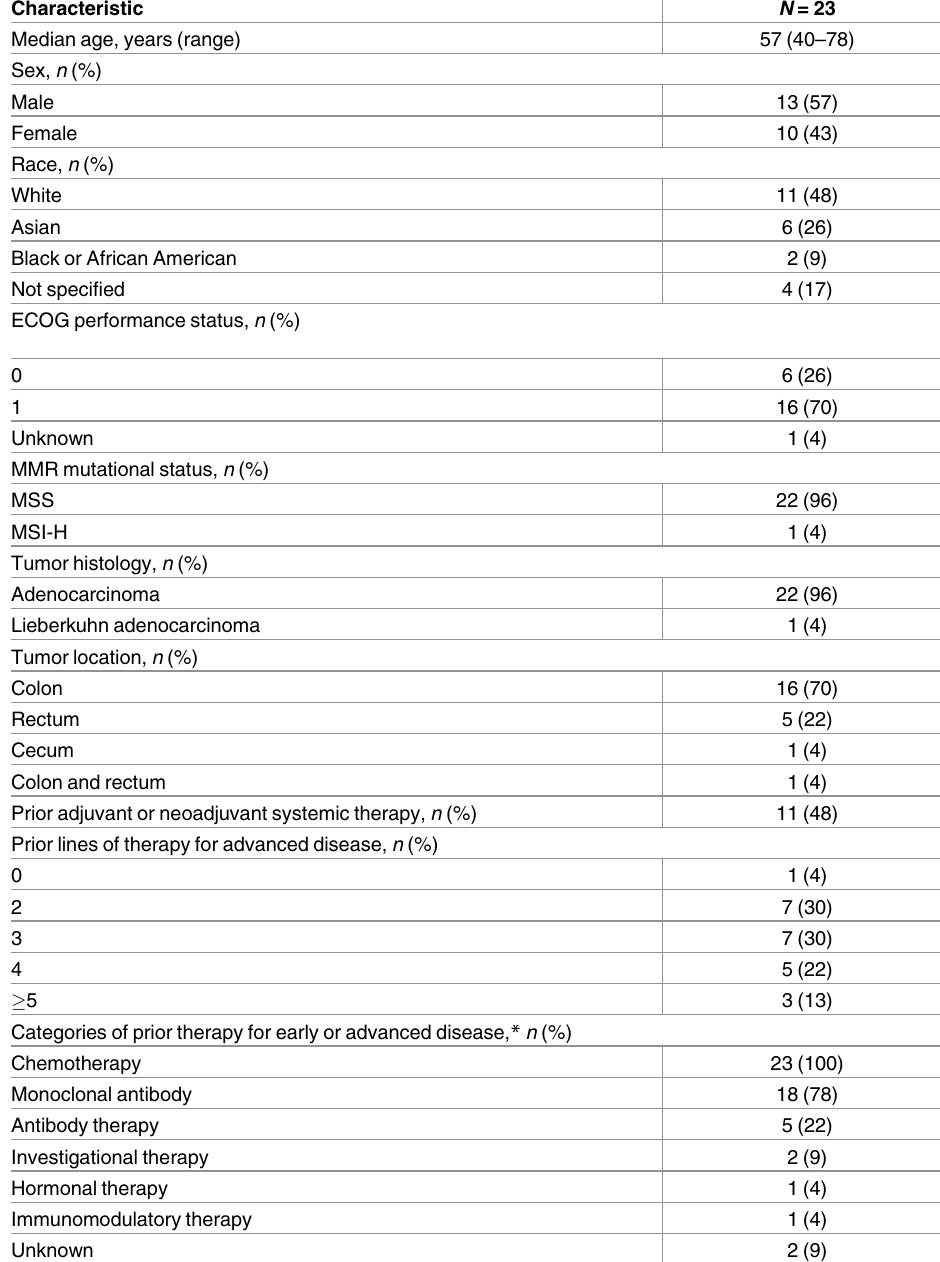
Table 1. Baseline demographics and clinical characteristics.